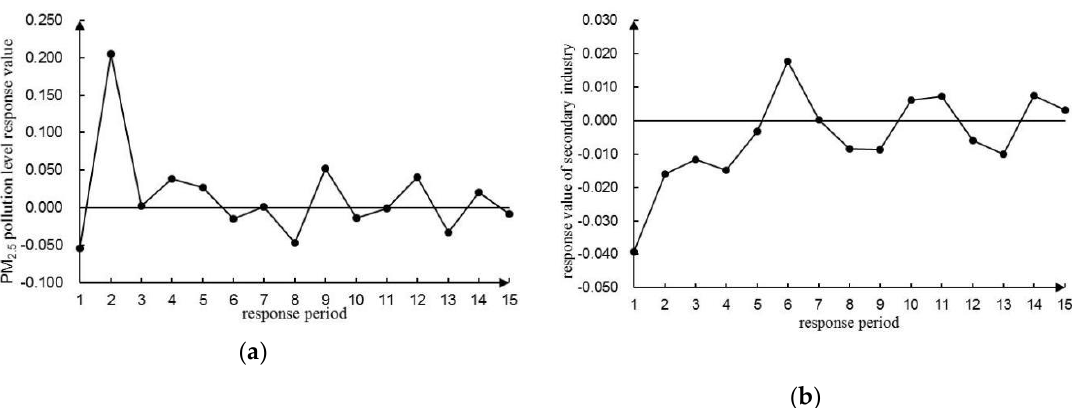
Figure 7. Impulse response function diagram of PM 2.5 pollution level and development level of the secondary industry. ( a ) Impulse response function diagram of the PM 2.5 pollution level to the secondary industry development level. ( b ) Impulse response function diagram of the secondary industry development level to the PM 2.5 pollution level.